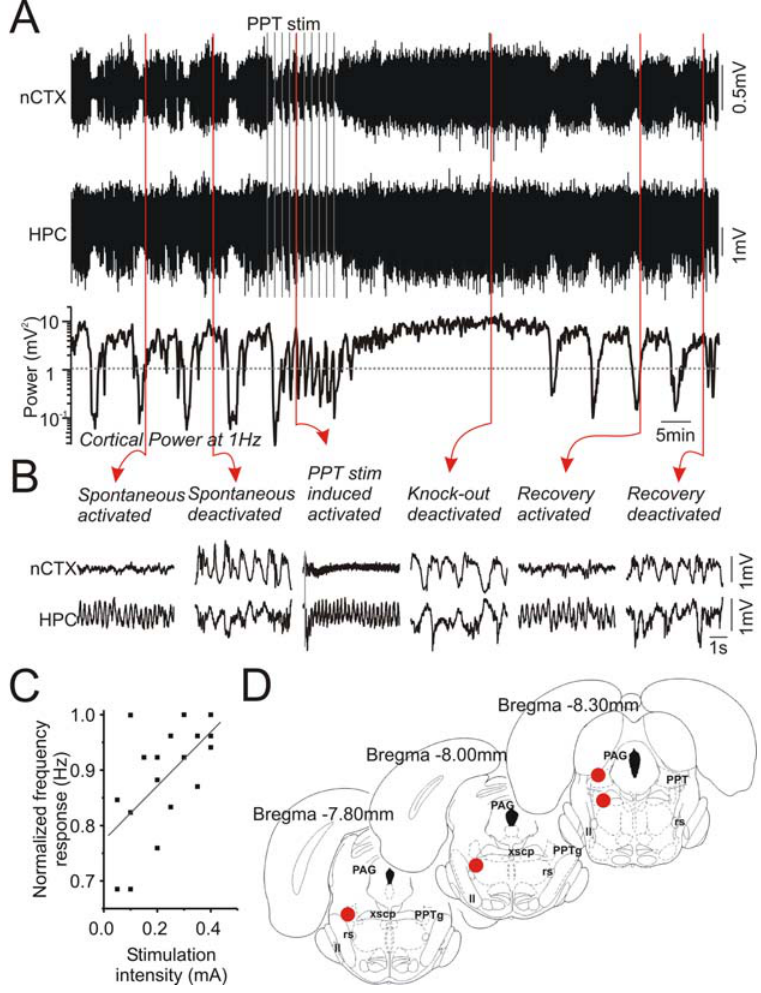
Figure 11. Stimulation trains applied to the pedunculo-pontine tegmentum temporarily abolished alternations of forebrain state. A) Continuous cortical and hippocampal EEG traces and the spectrographic cortical power at 1 Hz demonstrating the effects of stimulation of the pedunculo-pontine tegmental (PPT) region. Subsequent to a series of moderate stimulation trains, which were each effective in promoting an activated forebrain EEG during application, there was a transient suppression of forebrain state alternations. B) Expanded EEG traces from neocortical and hippocampal sites demonstrate that activated patterns were elicited via stimulation and that deactivated patterns follow a stimulation train. C) Scatterplot and linear fit of frequency as a function of the stimulation intensity in the PPT showing a significant (p , 0.01) relationship between stimulation intensity and the peak frequency of theta activity recorded in the hippocampus. The frequency was normalized across experiments to the maximal frequency of theta elicited in each. D) Summary of histological findings for the site of stimulation across experiments. Abbreviations: ll: lateral lemniscus, PAG: periaqueductal gray, PPT: pedunculo pontine tegmental nucleus, rs: rubrospinal tract, xscp: decussation of the superior cerebellar